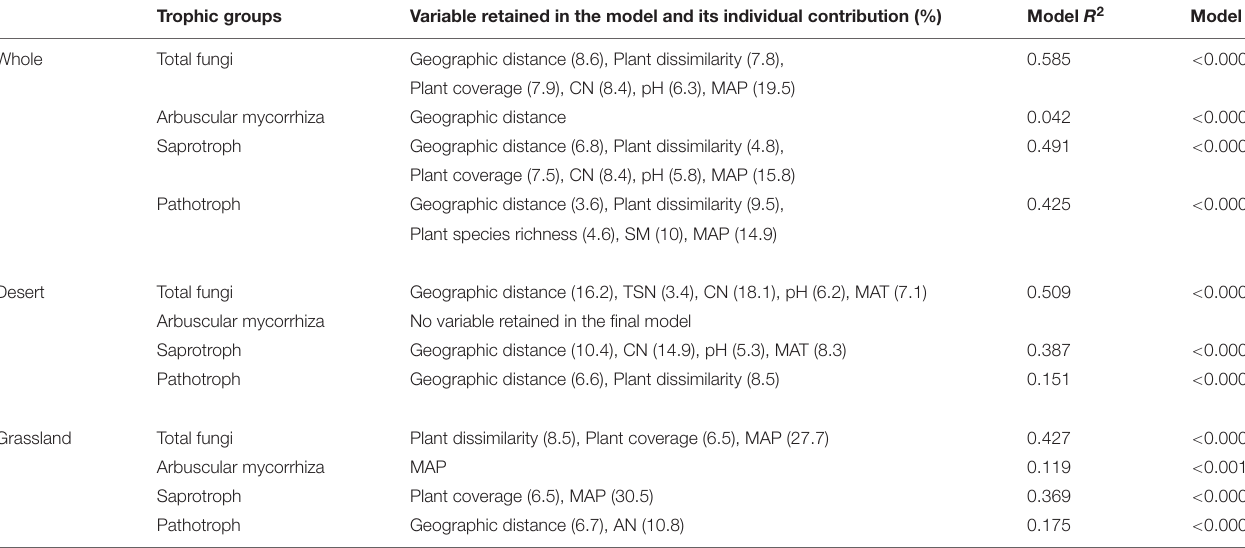
TABLE 3 | Results of the multiple regressions on distance matrices (MRM) for species compositions of different functional fungi in the desert, grassland and whole region. Trophic groups Variable retained in the model and its individual contribution